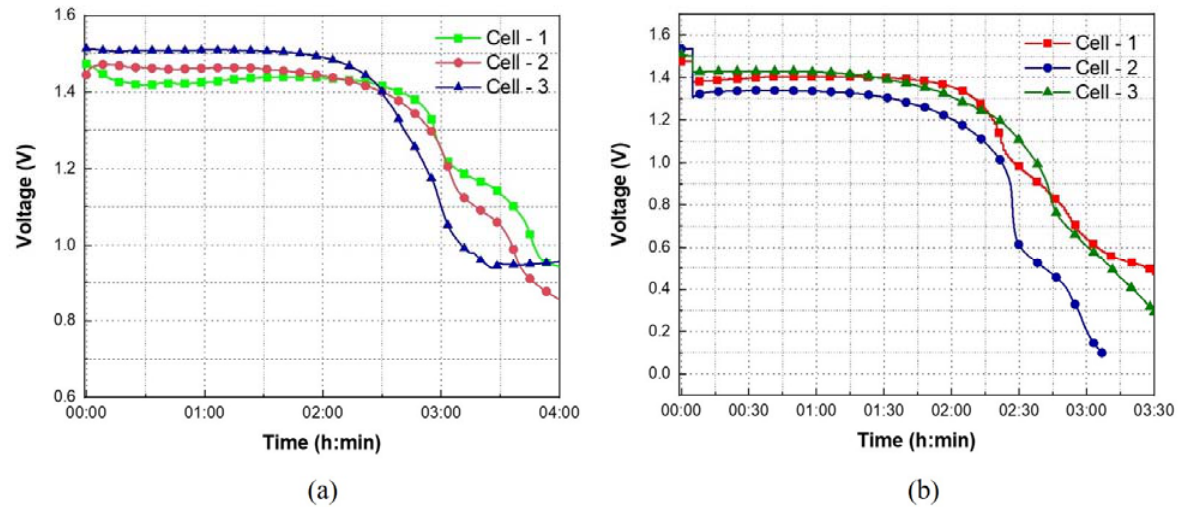
Figure 6. The ( a ) OCV and ( b ) discharge profiles of the stencil printed batteries with 5 wt% PEO-based gel electrolyte dried at 40 ◦ C for 10 min, repeated in